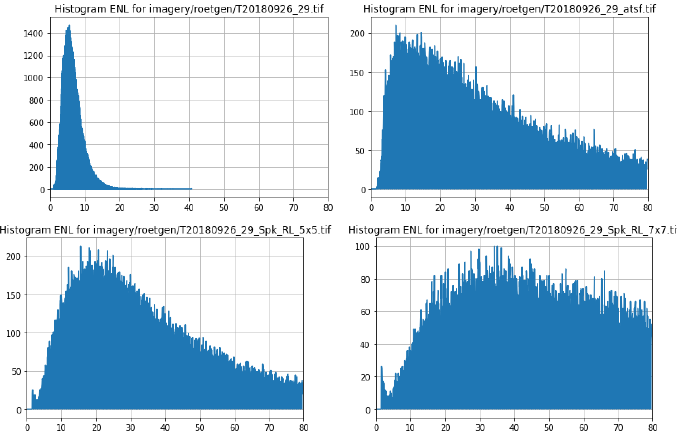
Figure 7. Histograms of the equivalent number of looks (ENL) for a Sentinel-1 scene over a wooded area in Germany; ( upper left ): for the target image acquired 26 September 2018; ( upper right ): for the ATSF using a time series of 29 images beginning 5 April and ending 26 September 2018; ( lower left ): for the refined Lee filter of the target image with a 5 × 5 kernel; ( lower right ): for the the refined Lee filter with a 7 × 7 kernel.